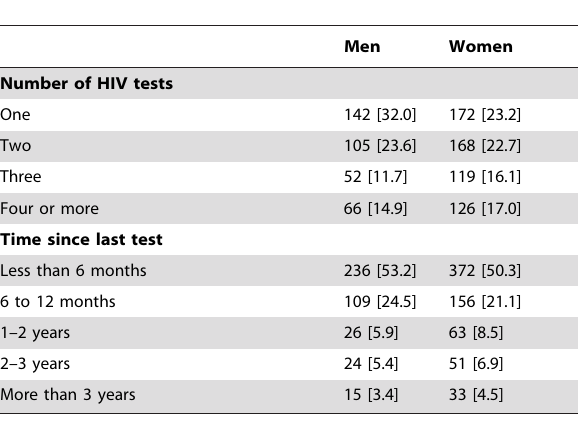
Table 2. Testing characteristics of respondents by gender and testing